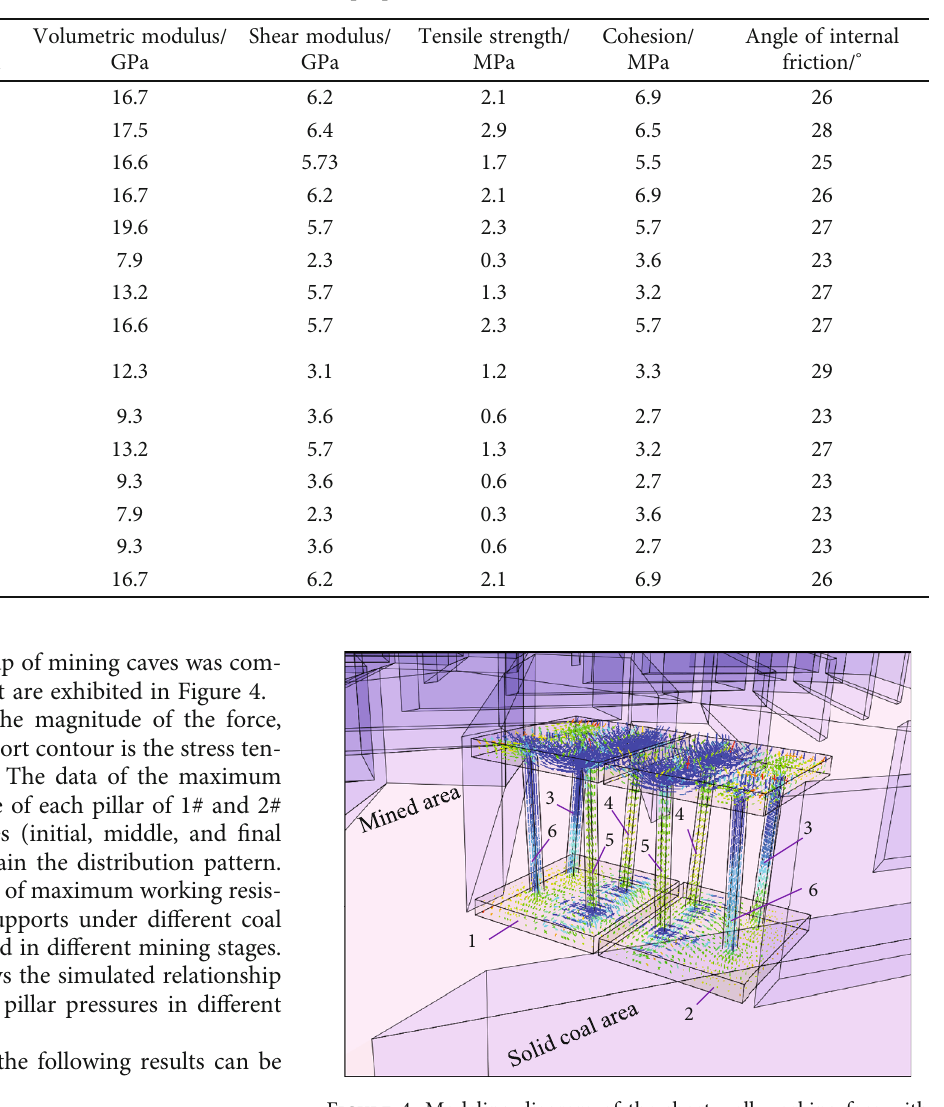
Table 1: Parameters of rock mechanical properties of numerical model.